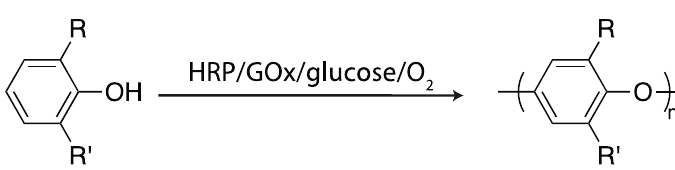
Figure 12. Utilizing horseradish peroxidase (HRP), glucose oxidase (GOx), glucose, and oxygen as a quaternary initiating system for polymerizing substituted phenols [96].